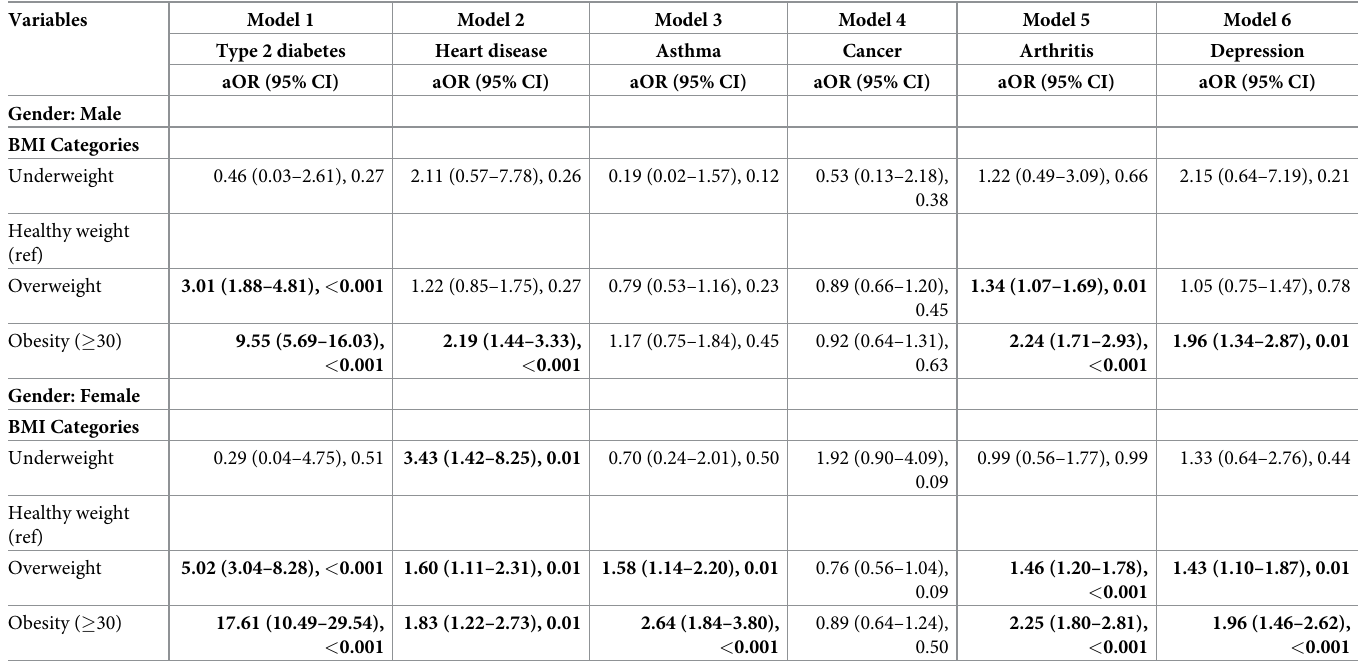
Table 4. Adjusted random-effect regression results for the between-person differences in chronic conditions due to obesity stratified by